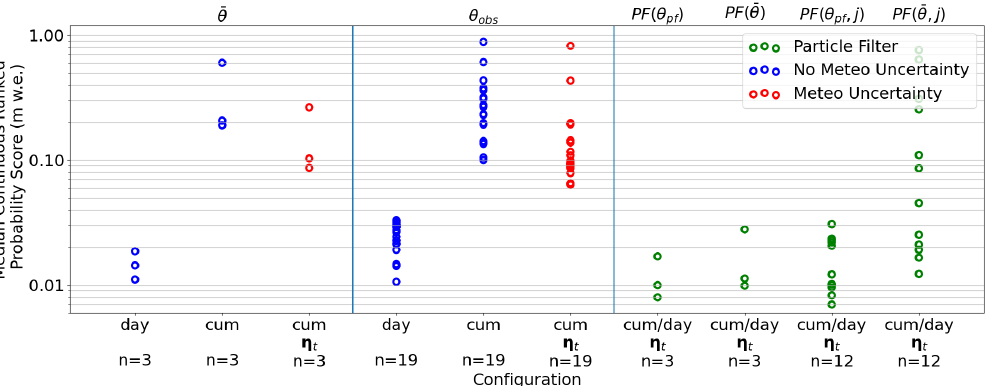
Figure 8. Median CRPS values over “ n ” validation cases for different forecasts. The following symbols are used: ¯ θ = mean parameters from past calibration; θ obs = parameters calibrated on different combinations of mass balance stake observations close to the cameras; θ pf = parameters found with the particle filter. Cases accounting for (red dots and analyses with “ η t ”) and neglecting (blue dots) the uncer- tainty in the meteorological variables are distinguished, and “cum” and “day” indicate the errors in the cumulative and daily mass balance predictions, respectively. For the particle filter (highlighted in green), the label “cum/day” indicates that the two errors coincide, and “j” indicates cases where the particle filter was run with only one